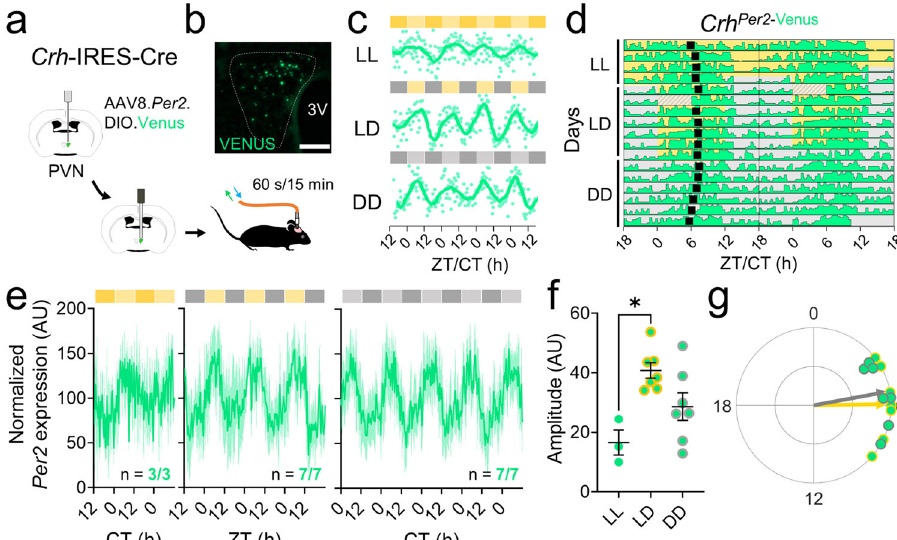
Fig. 1 PVN CRH neurons exhibit daily rhythms in clock gene expression that peak at midday. a Schematic of in vivo fi ber photometry recording of Per2 expression from targeted cells in the hypothalamic paraventricular nucleus (PVN) of Crh Cre/ + mice. b Representative ( n = 4 replicates) PVN (dashed line) image depicting Cre-dependent Venus expression (light green). 3 V, third ventricle. Scale bar = 100 µ m. c Representative in vivo Per2 -Venus fl uorescence from PVN CRH neurons averaged over 60 s every 15 min (light green dots) for 4 days from mice housed in constant light (LL), a 12 h:12 h light:dark cycle (LD), or constant darkness (DD). Data were smoothed with a 4 h Savitzky – Golay fi lter (light green line). ZT zeitgeber time; CT circadian time. d Representative double-plotted actogram of Per2 -Venus fl uorescence (light green) recorded from PVN CRH neurons in a mouse over 17 days in LL, LD, and DD. Black squares depict daily Per2 acrophases. Recording was interrupted for part of day 6 (hatched rectangle). e Normalized levels of Per2 expression from PVN CRH neurons in mice recorded in LL (dark yellow and yellow bars; n = 3/3 mice rhythmic, JTK cycle, p < 0.020 or less, see Supplementary Table 1 for p -values of individual mice), LD (gray and yellow bars; n = 7/7 mice rhythmic, JTK cycle, p < 0.001 for all mice), and DD (gray and light gray bars; n = 7/7 mice rhythmic, JTK cycle, p < 0.001 for all mice). Light green lines and shading depict mean ± SEM. f The peak-to-trough amplitudes of PVN CRH Per2 rhythms in LL, LD, and DD. n = 3, 7, 7 mice. Brown – Forsythe ANOVA with post-hoc Dunnett ’ s multiple comparison ’ s test, p = 0.007. Lines depict mean ± SEM. g Rayleigh plots of Per2 expression in PVN CRH neurons from mice housed in LD (light green dots with yellow outlines; peak time ZT 5.9, Rayleigh test, p = 0.001) and in DD (gray outlines; peak time CT 5.3, Rayleigh test, p = 0.001). In this and other Rayleigh plots, arrows point to the mean time of day when the rhythm peaked, and the length of the arrow indicates variability in the data ranging from 0 (peaked at random times) to 1 (all recordings peaked at the same time). Source data are provided as a Source Data fi Fig. 1g) when measured with Per2 -Venus or with a biolumines- cent reporter of Per2 (Supplementary Fig. 1d). Together, these results demonstrate that PVN CRH neurons exhibit sustained cir- cadian rhythms in gene expression in vivo that synchronize to the light cycle.